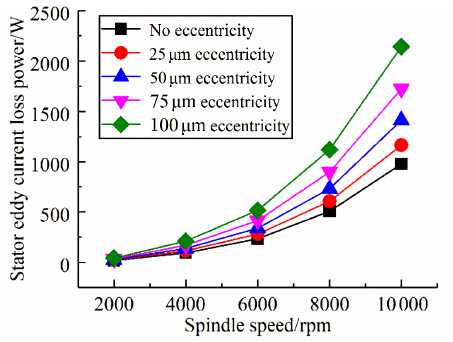
Figure 8. The stator eddy current loss power with different rotating speed and eccentricities.